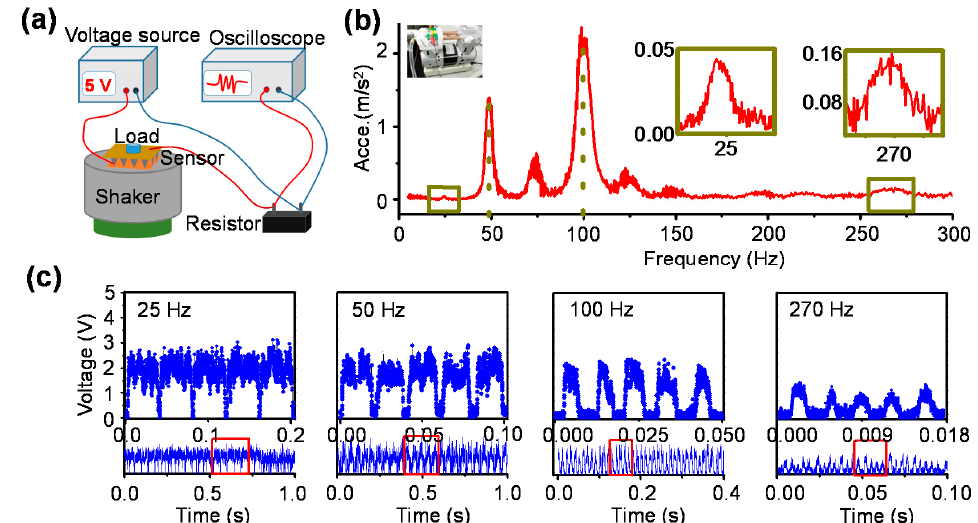
Figure 6. Mechanical vibrations detection. ( a ) The schematic illustration of mechanical vibration measurement platform. The vibrations provided by mechanical pump; ( b ) the relationship between accelerations and frequencies, which was calibrated by standard vibration sensor; ( c ) the typical vibrations with frequencies of 25, 50, 100 and 270 Hz were detected by our sensor.